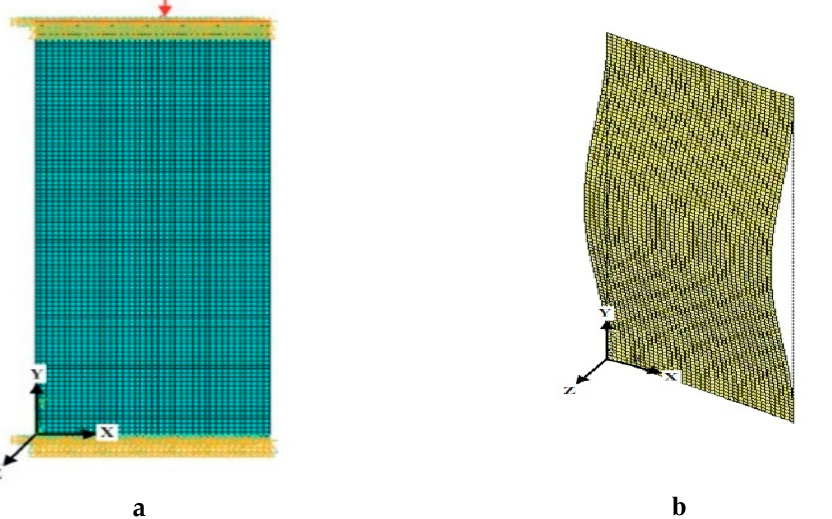
a b Figure 8. Meshed model ( a ); buckled model under a clamped–clamped end condition ( b ). Table 7. Comparison table of critical buckling loads obtained experimentally and numerically using ANSYS16. S.NO